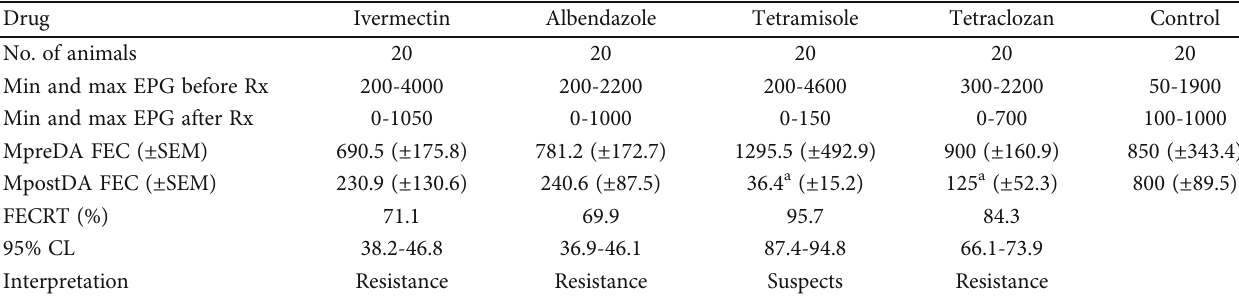
Table 1: Anthelmintic resistance test based on percentage faecal egg count reduction test (FECRT%) according to Coles et al. ’ s [22] methods.